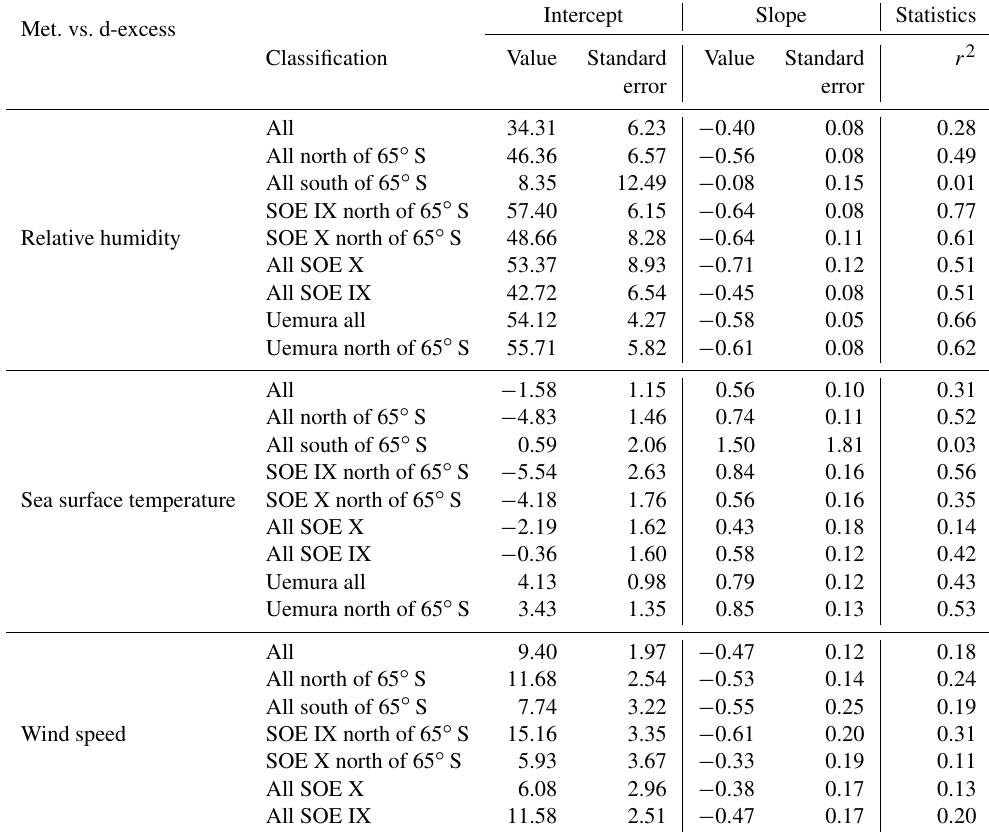
Table 2. Slope, intercept and r 2 of the linear regression equations between meteorological parameters (relative humidity, sea surface temper- ature and winds speed) and d-excess for different sample classifications. Also listed are the regression parameters for the data from Uemura et al.